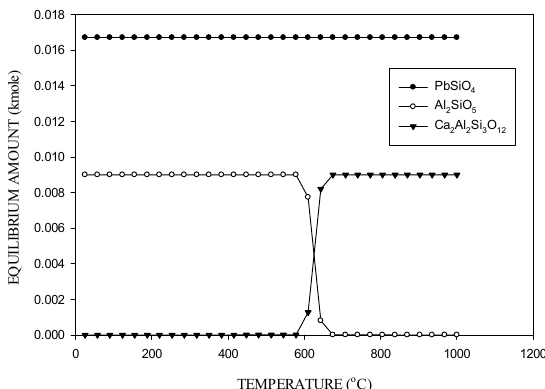
Figure 7. Behaviours of lead- and aluminium-containing species as a function of temperature for a sulphur dioxide addition of 0.68 kmole/100 kg of dust and 0.4 kmole of oxygen/100 kg of dust. As shown in Figure 8, copper and nickel behave in a similar manner. Both the copper and nickel sulphates are stable at room temperature, but their amounts decrease slowly with increasing temperature, and then more rapidly at about 600 °C, before disappearing at about 1000 °C. As the temperature increases, the copper and nickel ferrites form in increasing amounts, as well as the copper and nickel oxides. At 900 °C, the amounts of the ferrites reach a maximum before decreasing, and subsequently, the amounts of the nickel and copper oxides continue to increase. The amounts of copper and nickel sulphates could be increased by adding additional sulphur dioxide and oxygen, but this would also result in an increase in the amounts of the iron sulphates. TEMPERATURE ( o C) 0